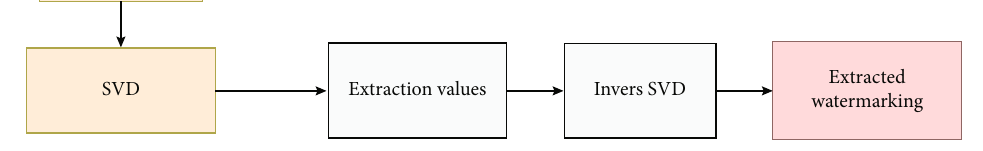
Figure 3: Feature extracting procedure. Table 1: System